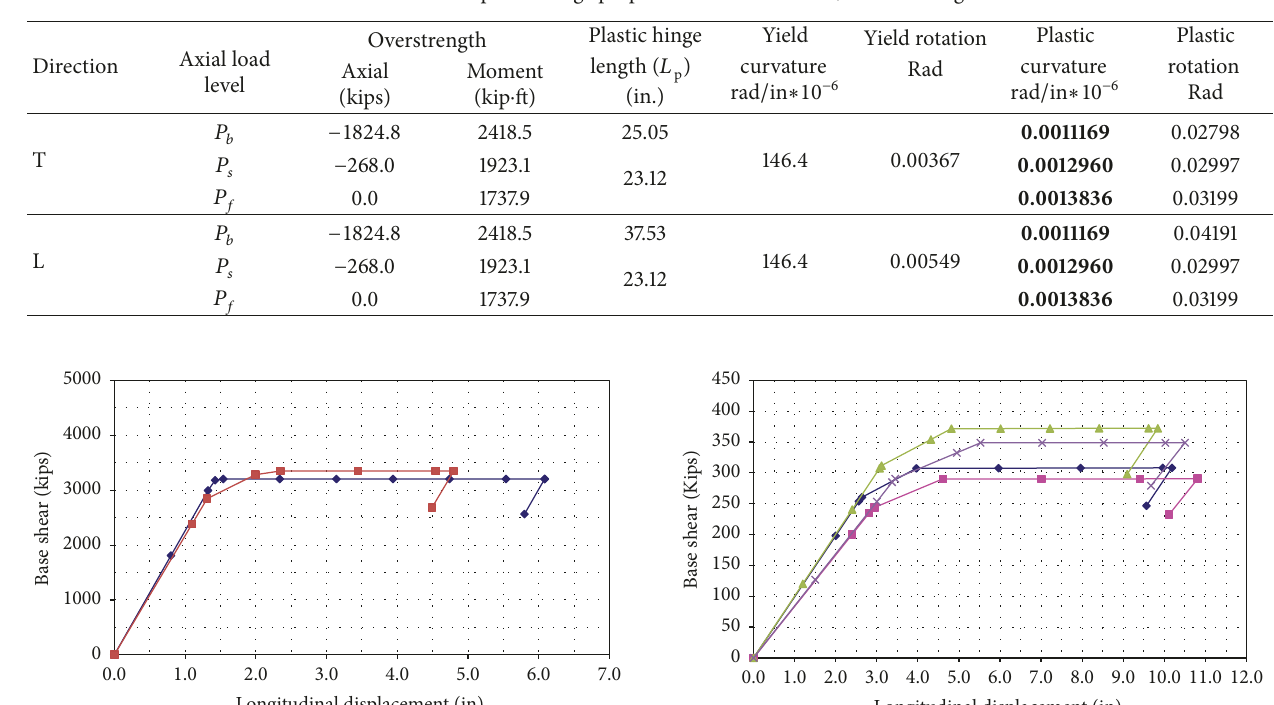
Table 15: User-defined plastic hinge properties of new columns, Pier #2 Bridge #4-W.